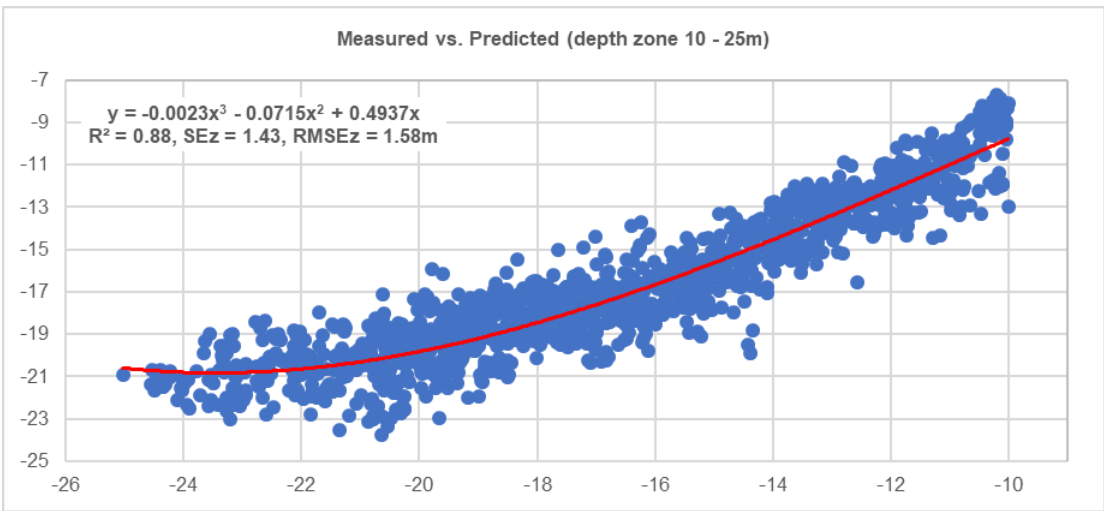
Figure 5. The validation plot for the depth zone of 10–25 m of in-situ depth points (x-axis) against image-derived bathymetries (y-axis) implementing the Lyzenga85 model on the image of 11/07/2017. 3rd order polynomial equation has been applied.